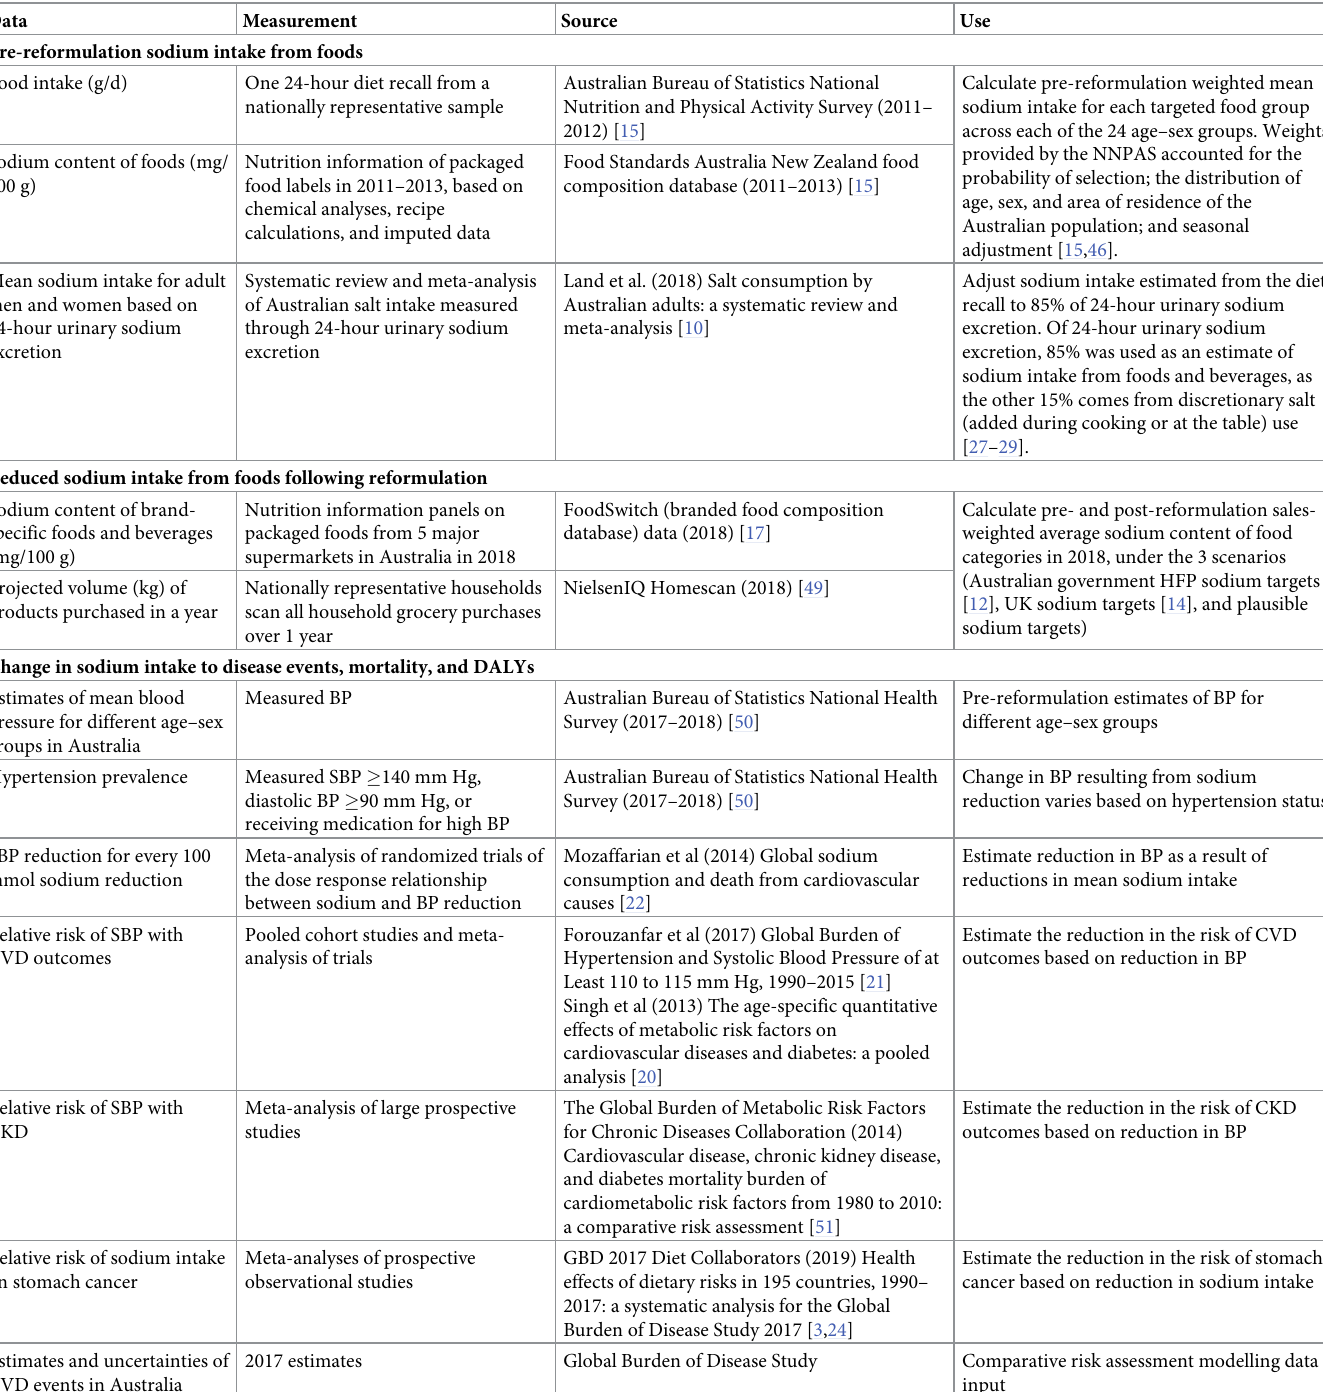
Table 1. Input data for comparative risk assessment on effect of sodium reformulation targets on death and disease burden in